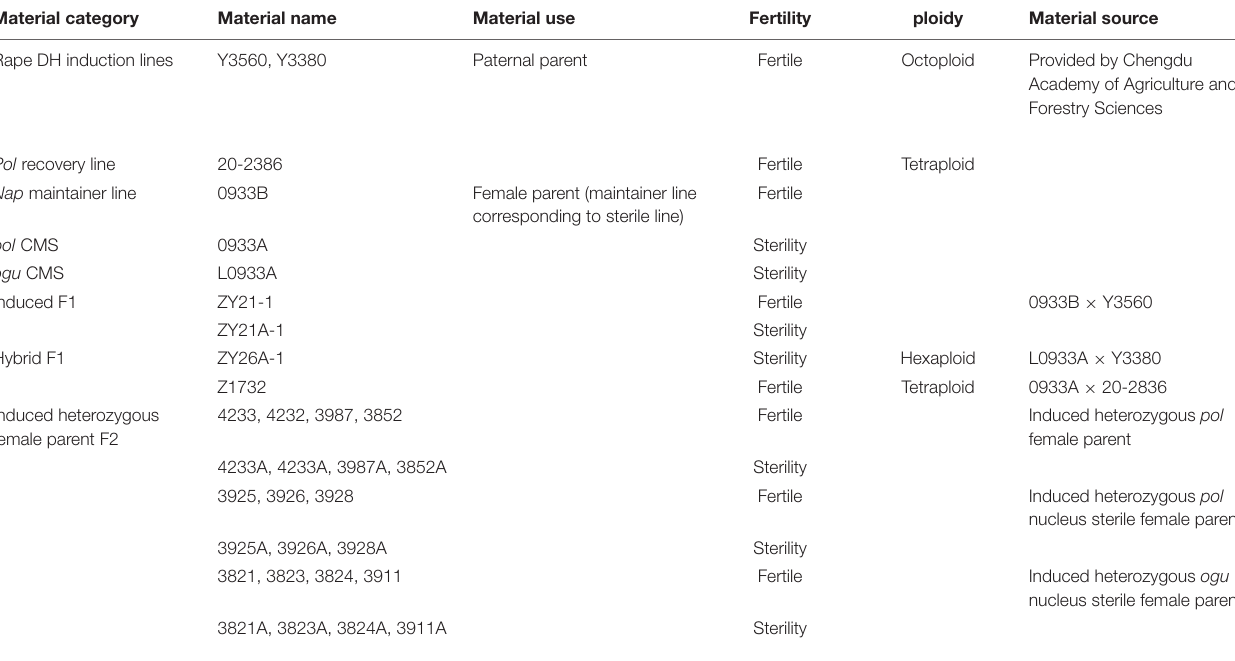
TABLE 1 | Test material